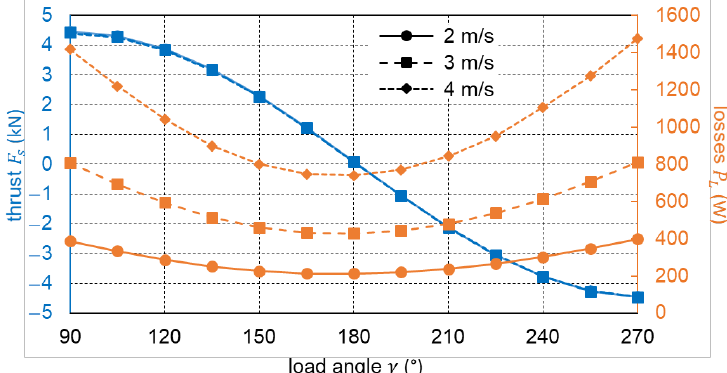
Figure 14. Thrust and loss characteristics as functions of the load angle and speed.